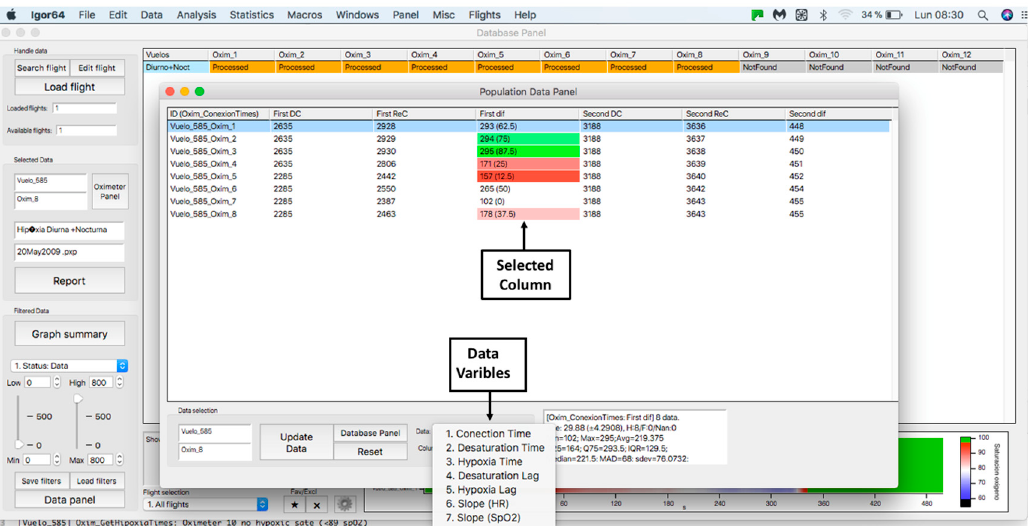
Figure 16. Display of “data” subpanel and selected column.